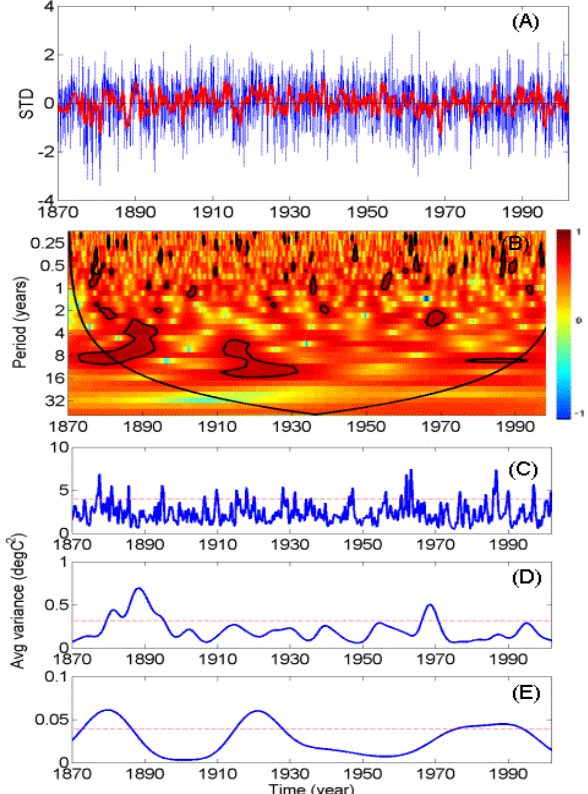
Fig. 4. North Atlantic Oscillation (NAO) Analysis: (a) Monthly Figure 4 – North Atlantic Oscillation (NAO) Analysis: (a) Monthly time series of the NAO time series of the NAO index: The blue line shows the monthly data index: The blue line shows the monthly data and the red line is a 13-month running mean; (b) wavelet spectrum: The black contours mark the significant region at 5% and the U-shaped huge and the red line is a 13-month running mean; (b) wavelet spectrum: black line delimits the region where the edge effects are important; (c), (d) and (e): Variances of The black contours mark the significant region at 5% and the U- the filtered time-series on scale seasonal, interannual and decadal time scales, respectively. shaped huge black line delimits the region where the edge effects are important; (c) , (d) and (e) Variances of the filtered time-series on seasonal, interannual and decadal time scales, respectively.